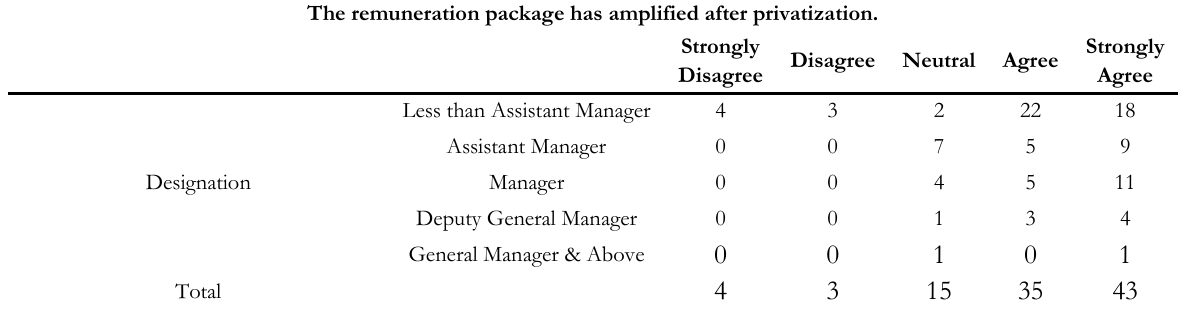
Table 5: DSG * Q7 Cross tabulation The remuneration package has amplified after privatization.